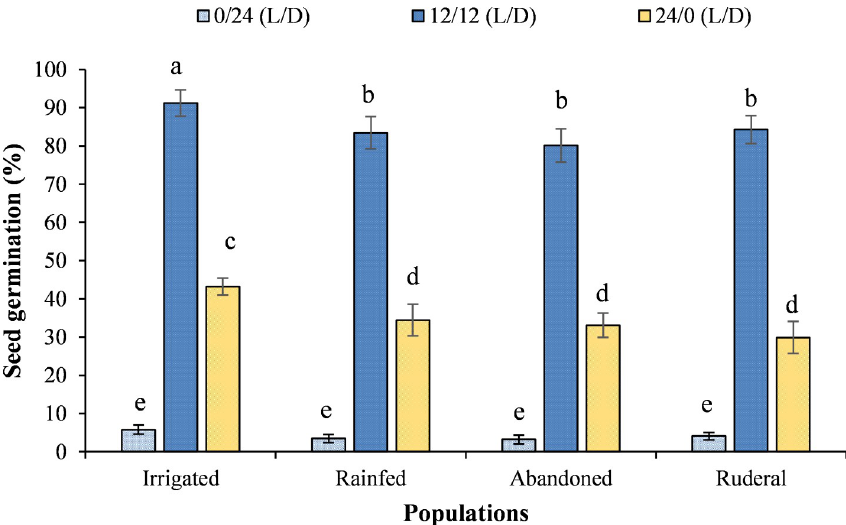
Fig 1. The influence of different light/dark durations on seed germination Conyza stricta Willd. The vertical bars present standard errors of means (n = 10). Any to means sharing same letter are statistically non-significant (p > 0.05). LDS 0.05 =